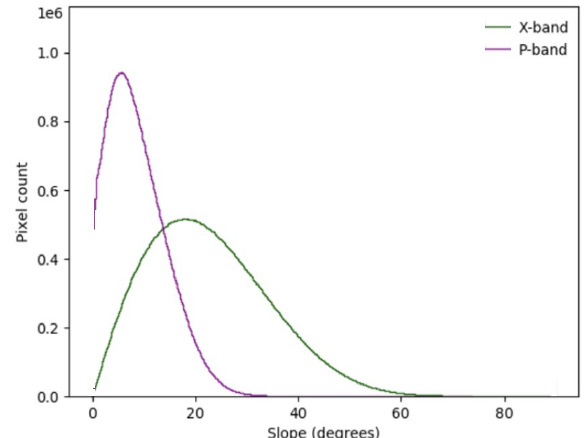
Figure 4. Slope histograms of the DEMs obtained from P-band and X-band radar in area B (adapted from Ećo